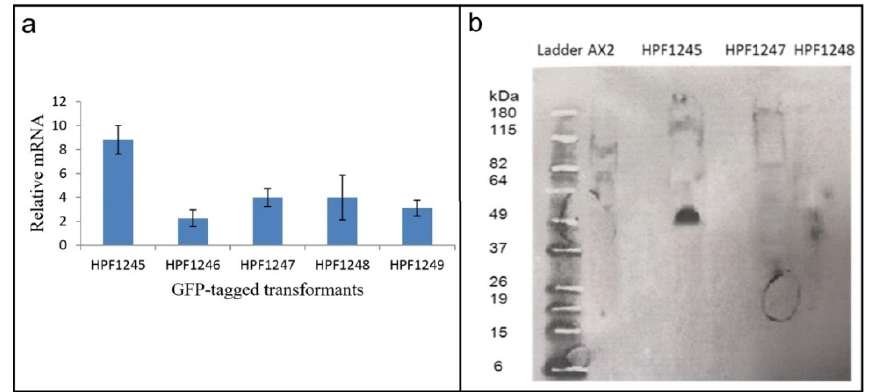
Figure 6. GFP mRNA is expressed in HTRA2: GFP fusion transformants, but the protein is not. HTRA2: GFP fusion transformants were isolated and shown to contain the full length htrA and GFP sequences (Figure S7). The GFP mRNA was expressed in these transformants but the protein was not. (a) Transcription of GFP in DJ-1: GFP and HTRA2: GFP transformants. HPF1245 and HPF1246 are the DJ-1: GFP expression transformants and HPF1247, HPF1248 and HPF1249 are the HTRA2: GFP transformants. The GFP mRNA was measured and normalized against filamin. GFP coding sequence was transcribed in all GFP-tagged D. discoideum transformants. Error bars are standard errors of the mean from duplicate measurements. (b) Expression of GFP fusion protein in DJ-1:GFP and HTRA2:GFP transformants. The Western blot includes protein from AX2 (negative control), HPF1245 expressing GFP-tagged DJ-1 (52 kDa) (positive control), and HPF1247 and HPF1248 containing constructs for expressing GFP-tagged HTRA2. No GFP could be detected in the HTRA2:GFP transformants. The amount of protein loaded in each well was 300 µ g (Bradford